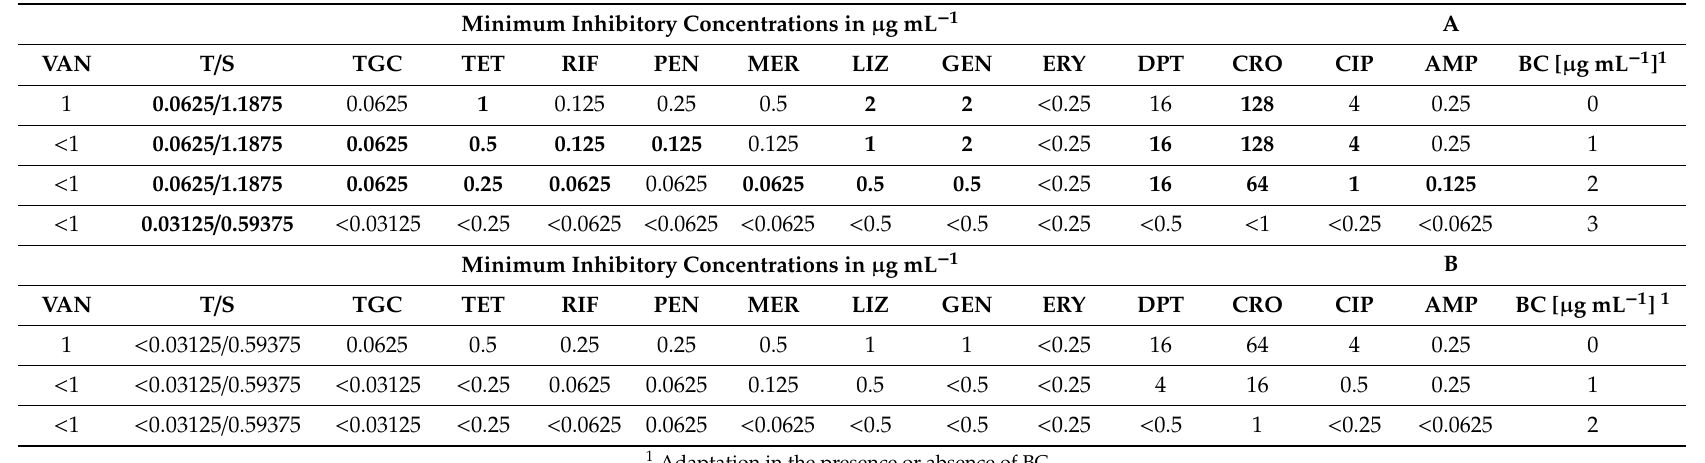
Table 1. Antibiotic susceptibility profiles of adapted ( A ) and parent ( B ) Listeria monocytogenes SLCC2540 cells after growth in BHI supplemented with benzalkonium chloride (BC). Di ff erences in the susceptibility profiles of adapted and parent cells are highlighted in bold. Antibiotics are AMP, ampicillin; PEN, benzylpenicillin; CRO, ceftriaxone; CIP, ciprofloxacin; DPT, daptomycin; ERY, erythromycin; GEN, gentamicin; LIZ, linezolid; MER, meropenem; RIF, rifampicin; TET, tetracycline; TGC, tigecycline; T / S, trimethoprim / sulfamethoxazole; VAN,